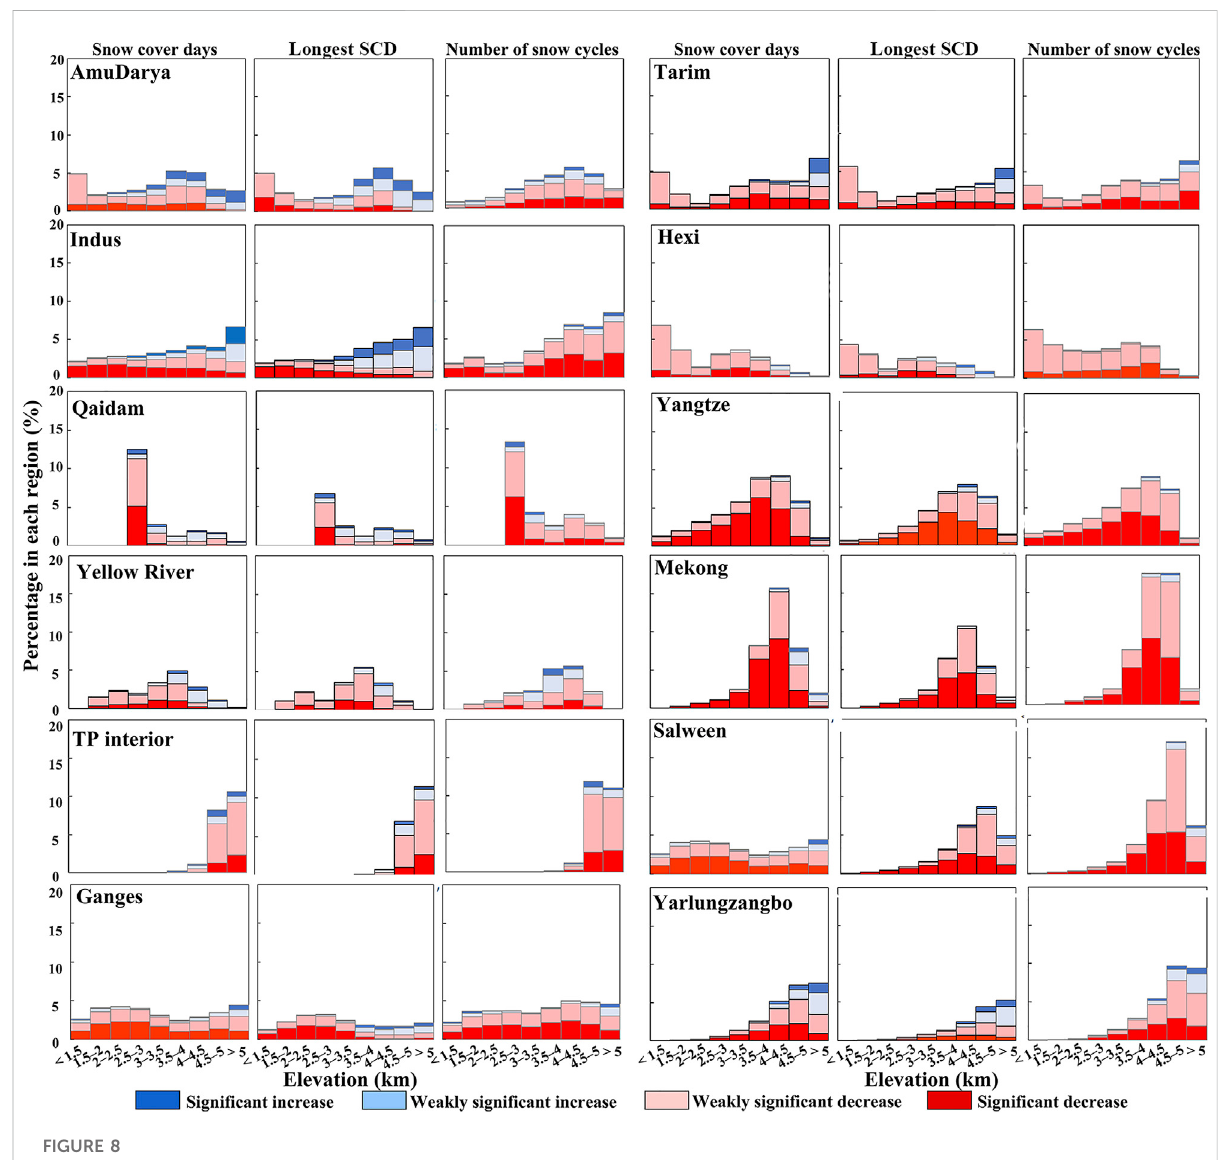
FIGURE 8 Percentage of snow cover increase and decrease areas in each